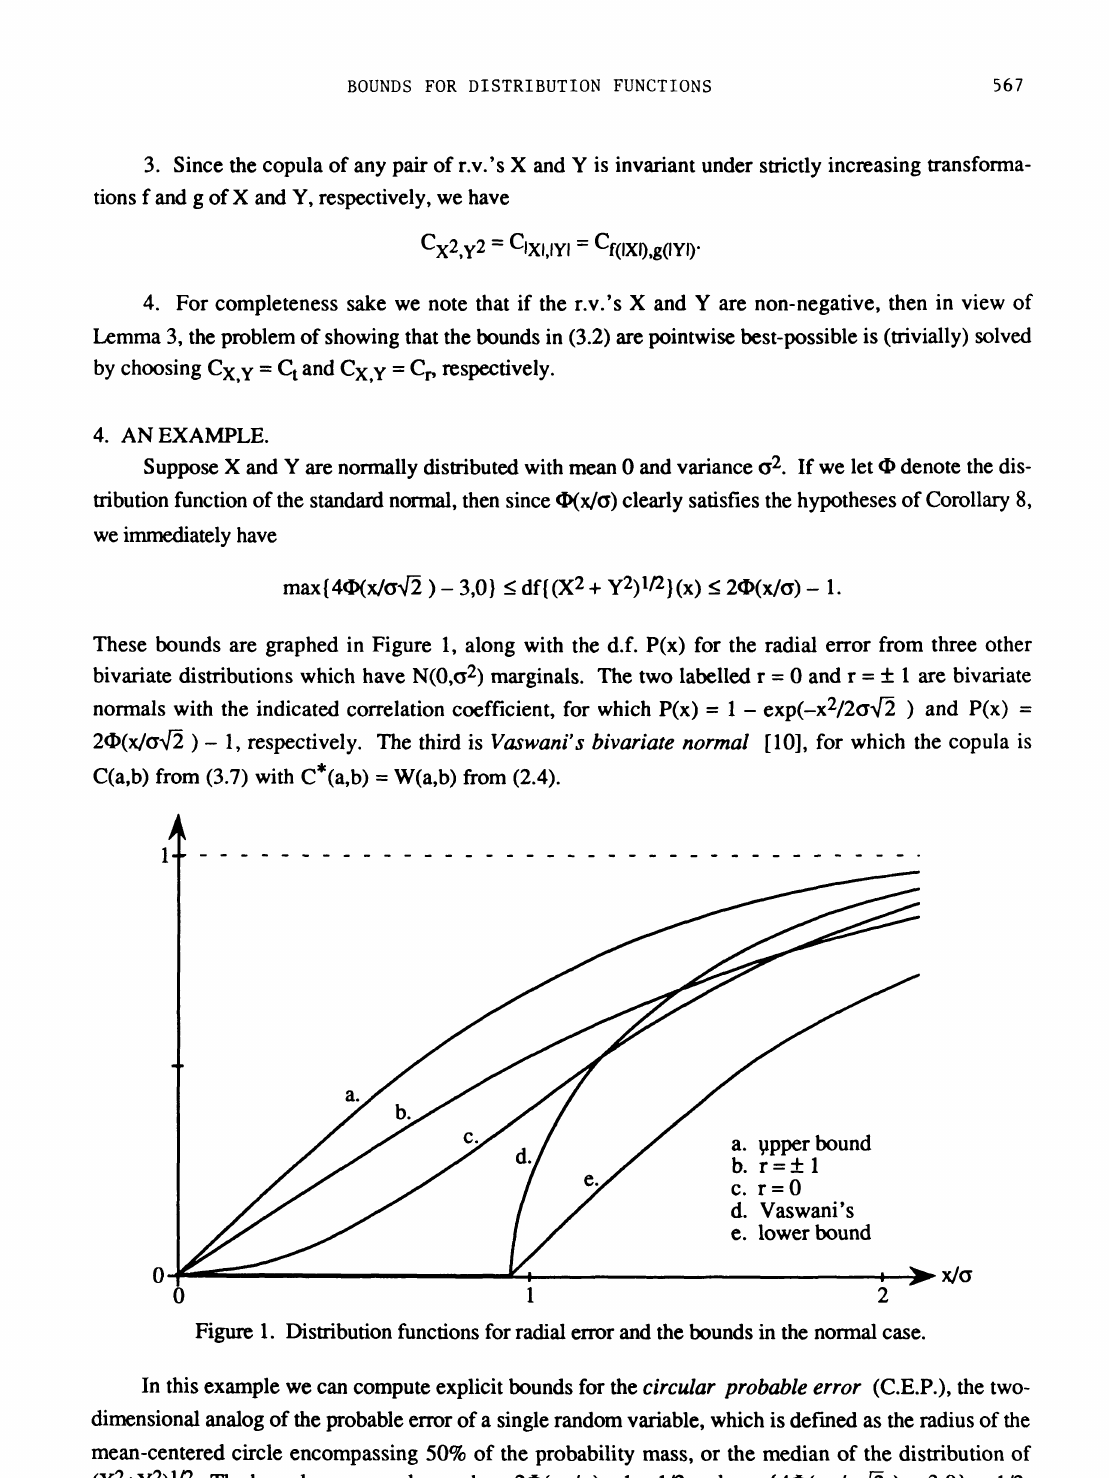
Figure I. Distribution functions for radial error and the bounds in the normal